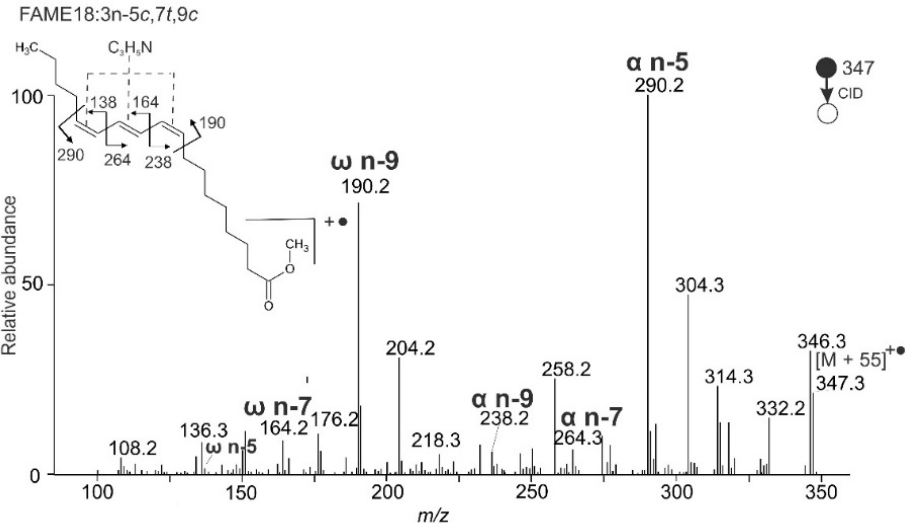
Figure 2. APCI MS/MS CID spectrum of [M + 55] + • adduct of punicic acid methyl ester (FAME 18:3n- 5 c ,7 t ,9 c ); MBR = 290 + 190 − 347 = 133.